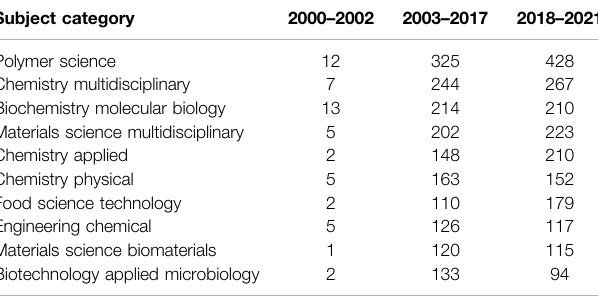
TABLE 1 | Article output in 10 subject categories of natural biopolymer